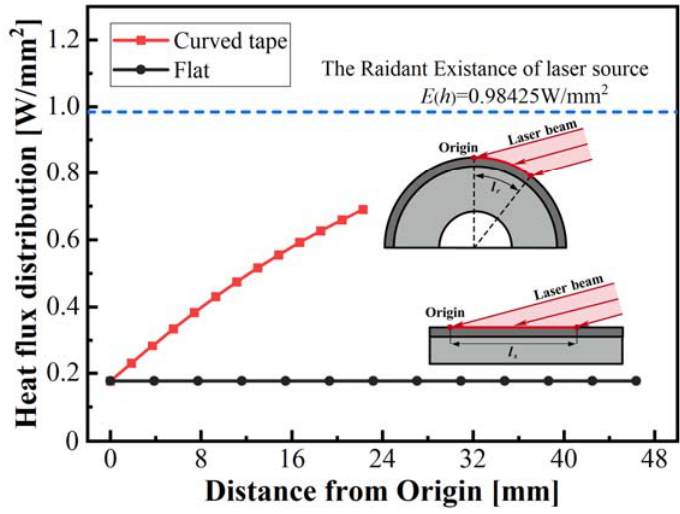
Figure 10. Comparison of heat flux distribution in curved tape and flat specimen.